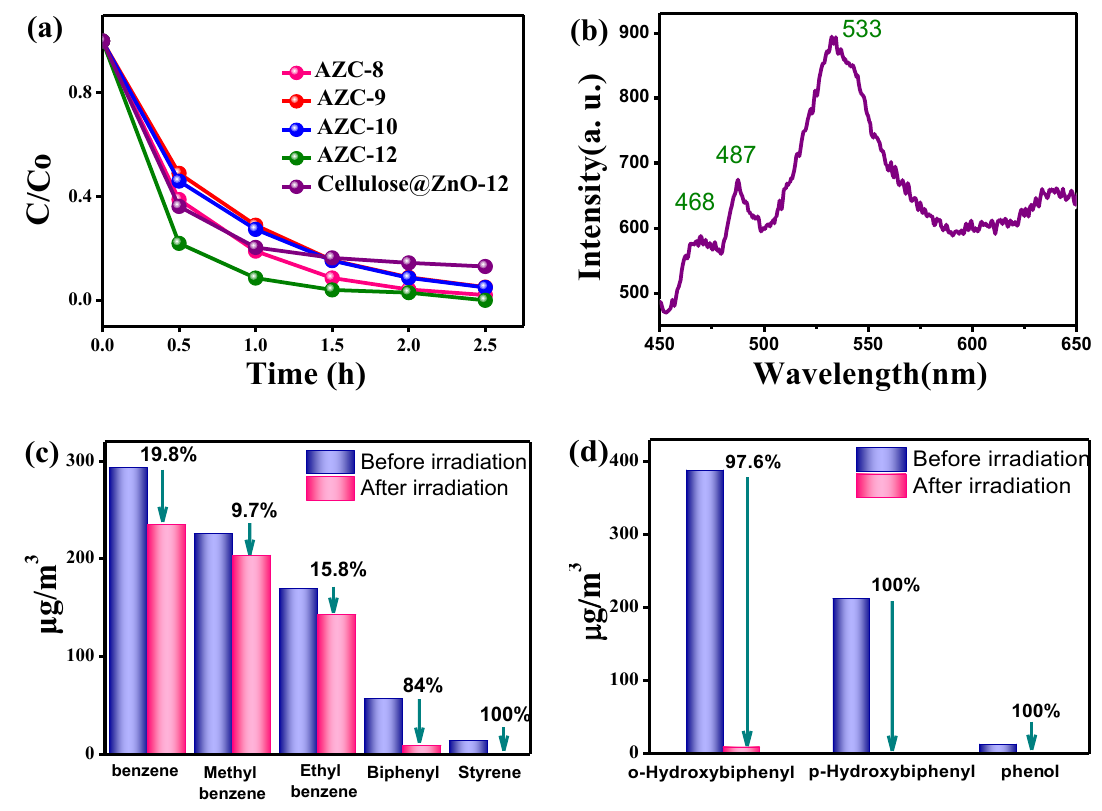
Figure 5: Photocatalytic activity of ZAC composite evaluated by MB (a), PL spectrum of ZAC-12 (b), degradation of benzene, phenol and derivatives by ZAC (c and d).